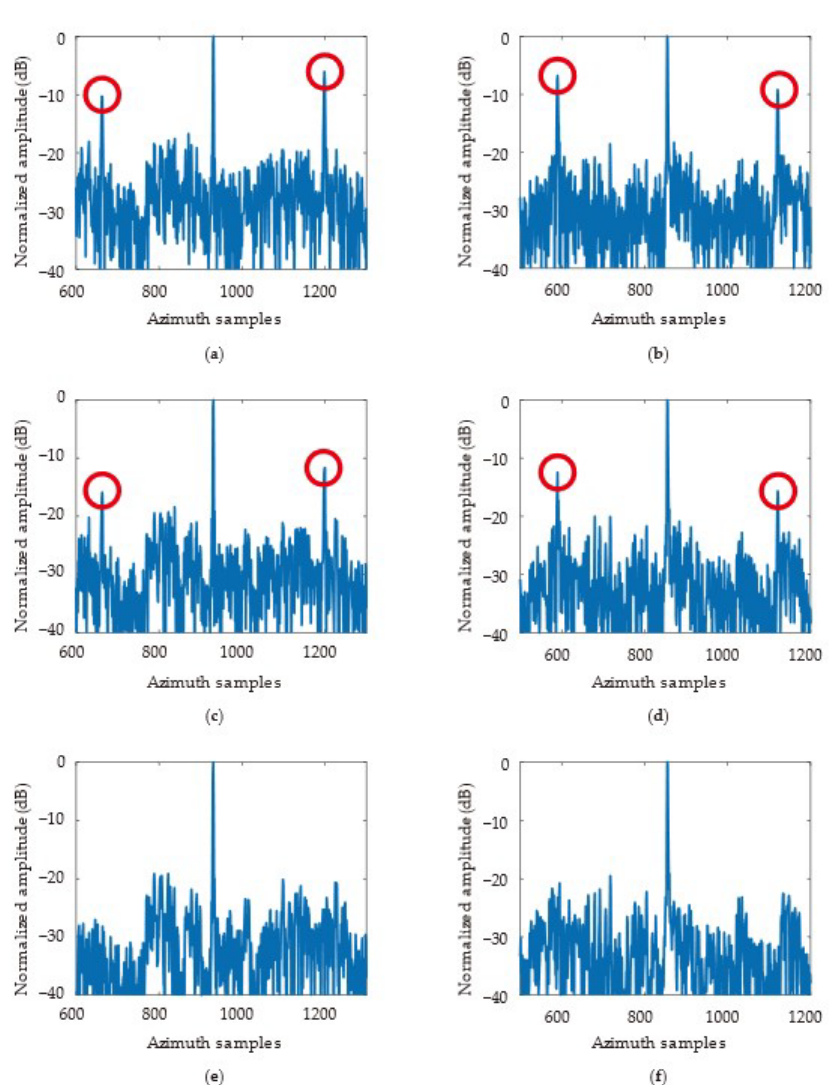
Figure 14. Azimuth cut of the distributed SAR imaging results. ( a ) Azimuth cut of the single-channel undersampling imaging results for Target A. ( b ) Azimuth cut of the single-channel undersampling imaging results for Target B. ( c ) Azimuth cut of the traditional method imaging results for Target A. ( d ) Azimuth cut of the traditional method imaging results for Target B. ( e ) Azimuth cut of the proposed method imaging results for Target A. ( f ) Azimuth cut of the proposed method imaging results for Target B. Table 4. The AASR of the targets in Figure